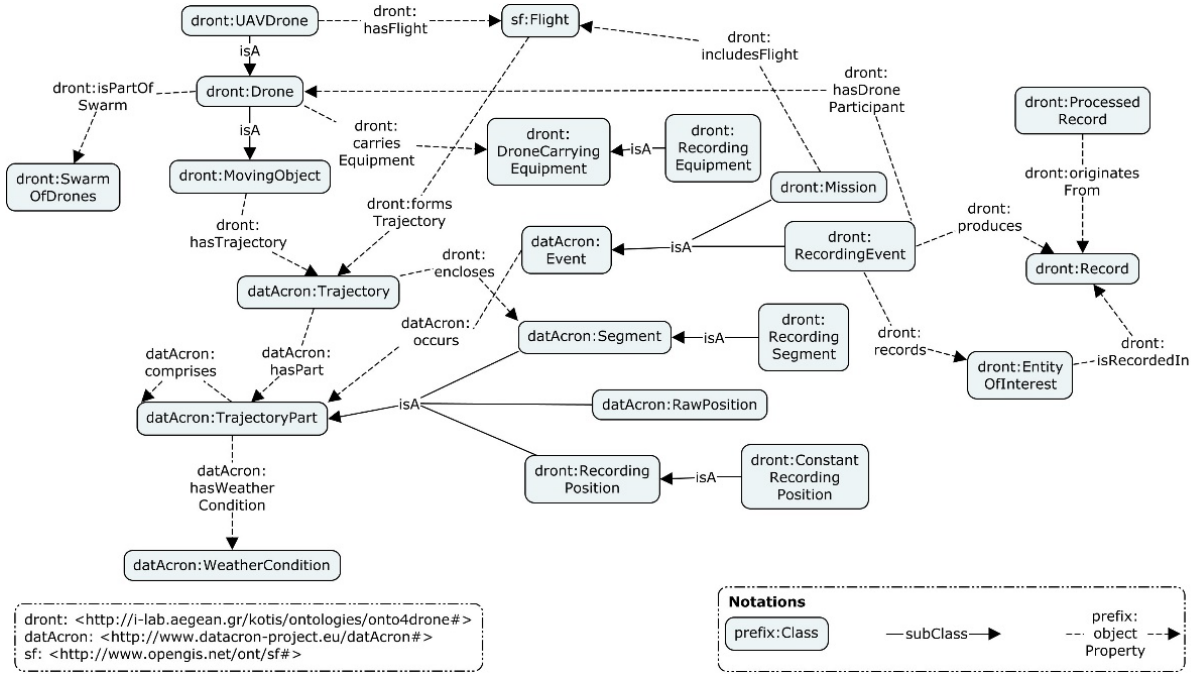
Figure 4. Basic concepts and relations of the STaKG ontological model representing drones and recording episodes.